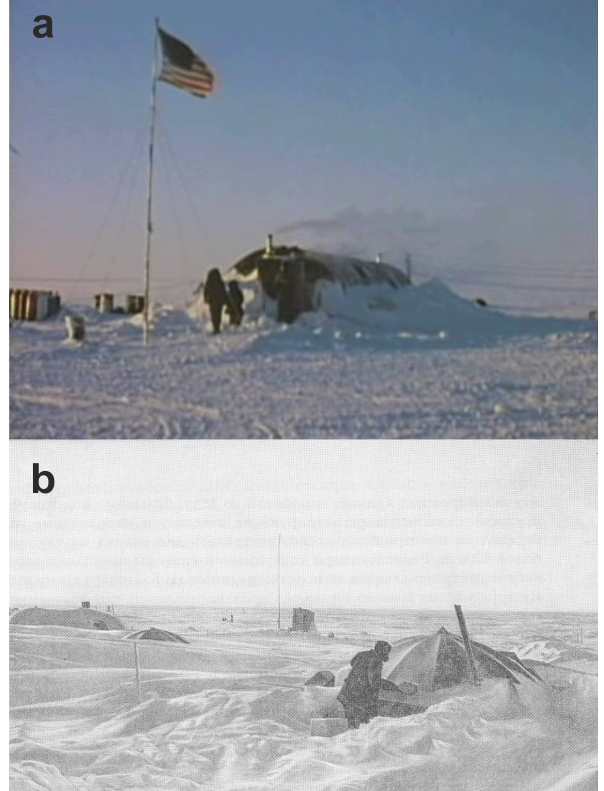
Figure 8. American and Soviet polar explorers at the IGY drifting stations in the Arctic Ocean: (a) US station Alpha (Untersteiner, 2009); (b) Soviet station SP-7 (“North Pole-7”) (Rodnikov et al.,